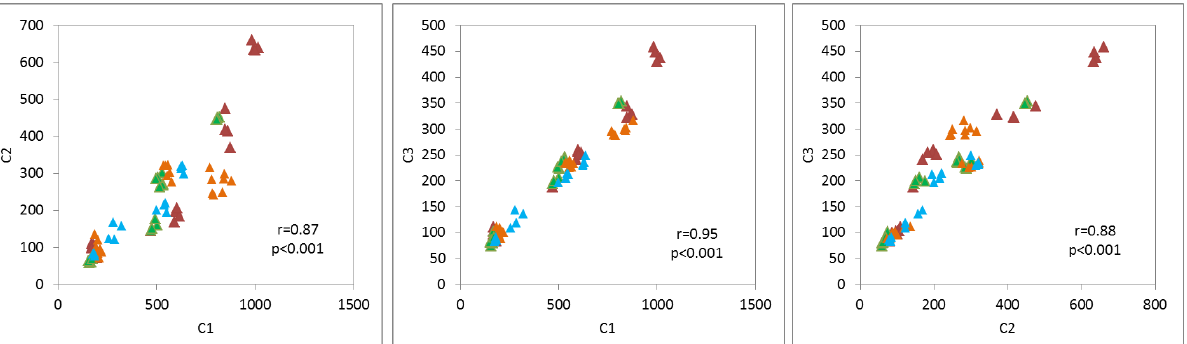
Fig. 5. Spearman’s rank correlation between the PARAFAC components C1, C2 and C3 (Table 2). C1:C2 (left), C1:C3 (middle), C3:C2 (right). Correlations are based on single values ( n = 98). Colours of triangles indicate spring (green), summer (red), autumn (orange), and winter (blue). All correlations are highly significant ( p < 0 .